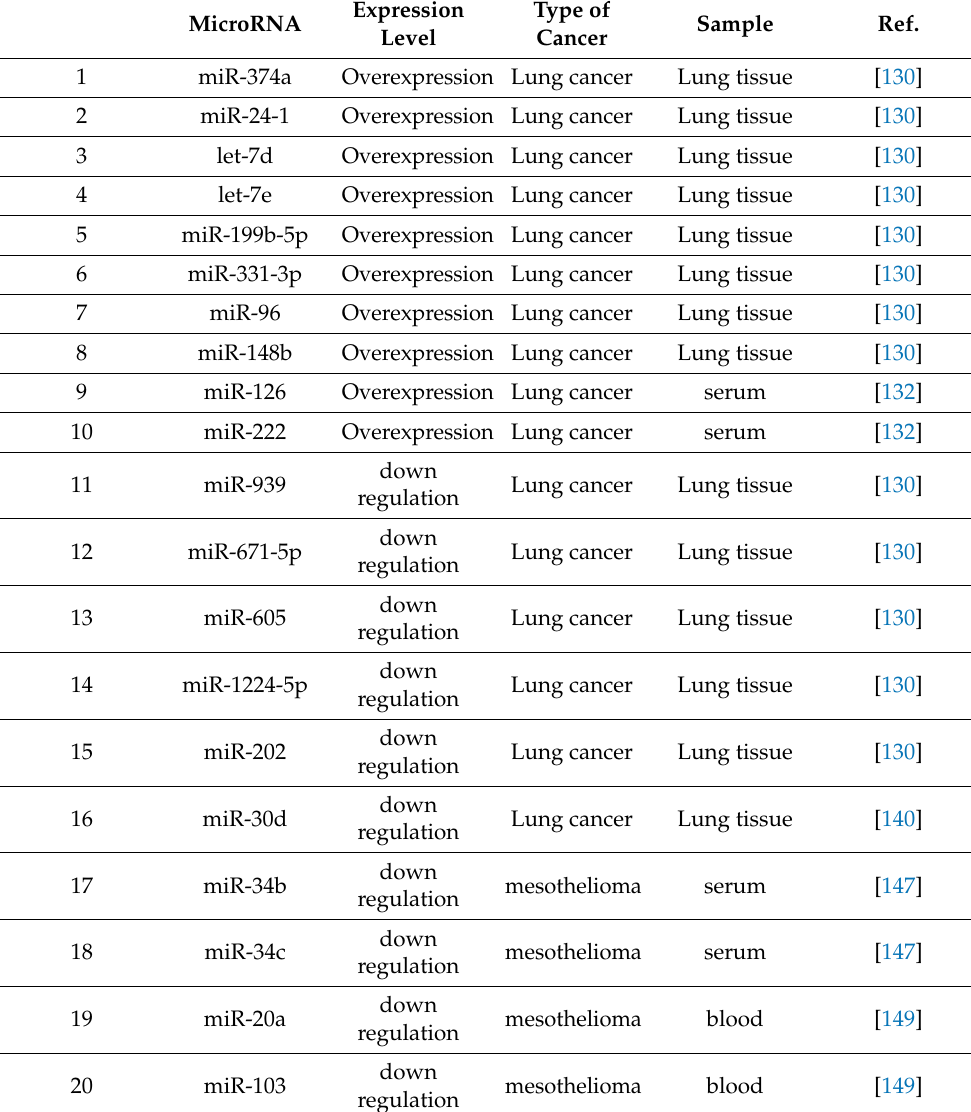
Table 3. MicroRNAs whose expression profile changed under the influence of